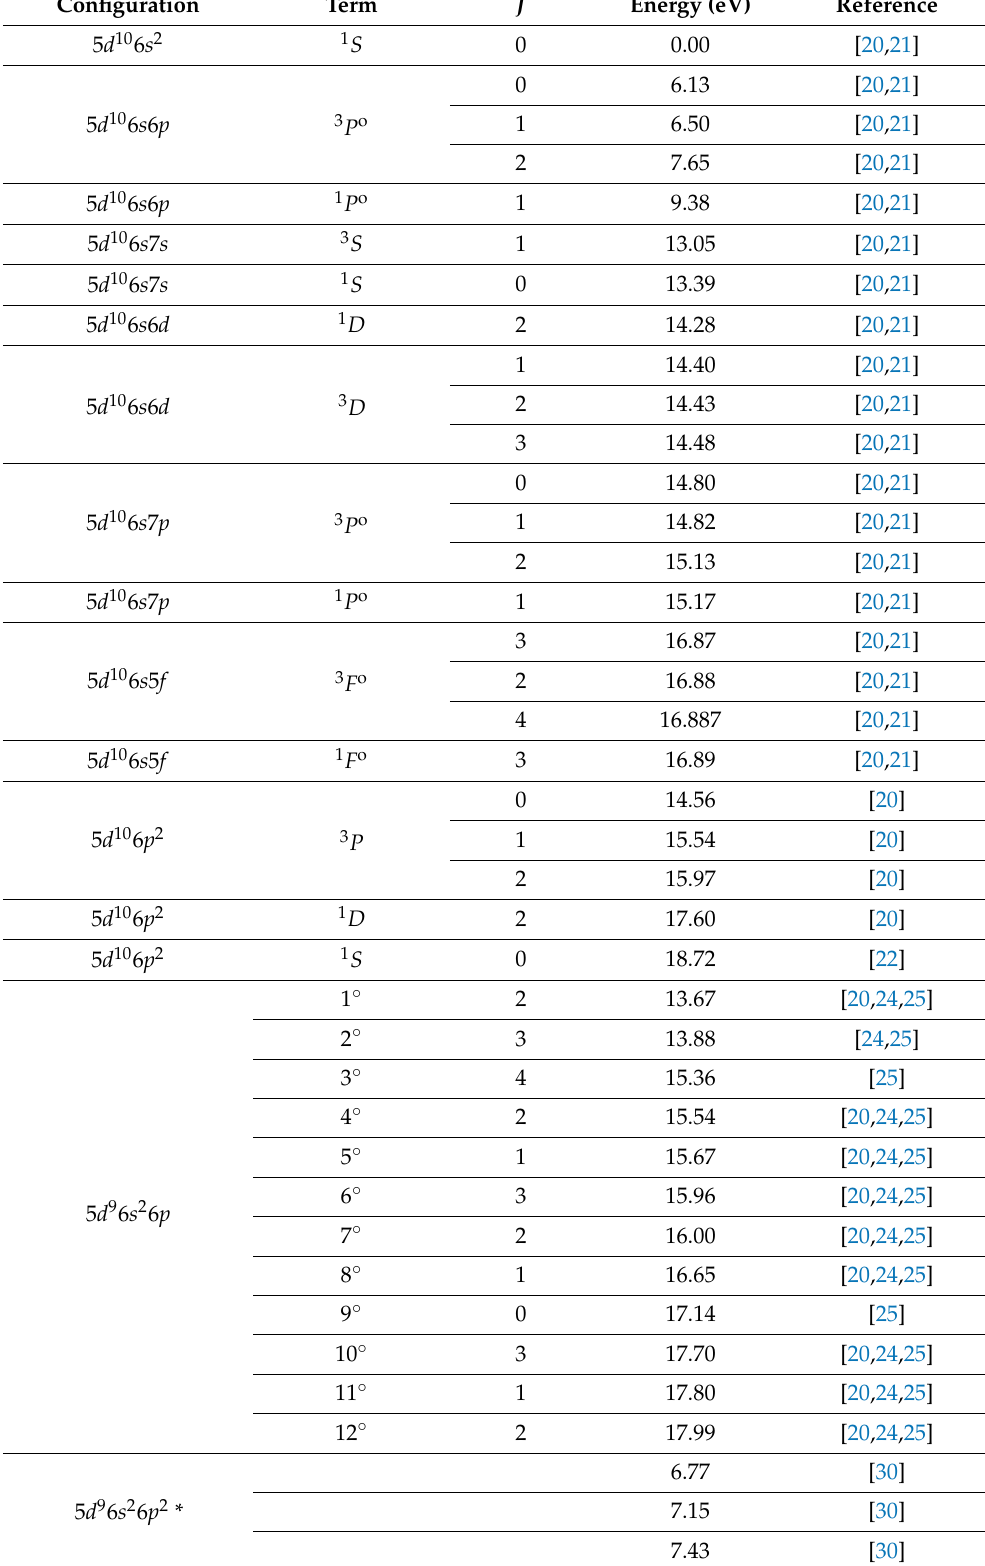
Table 1. Energies of the Tl + and Tl levels.